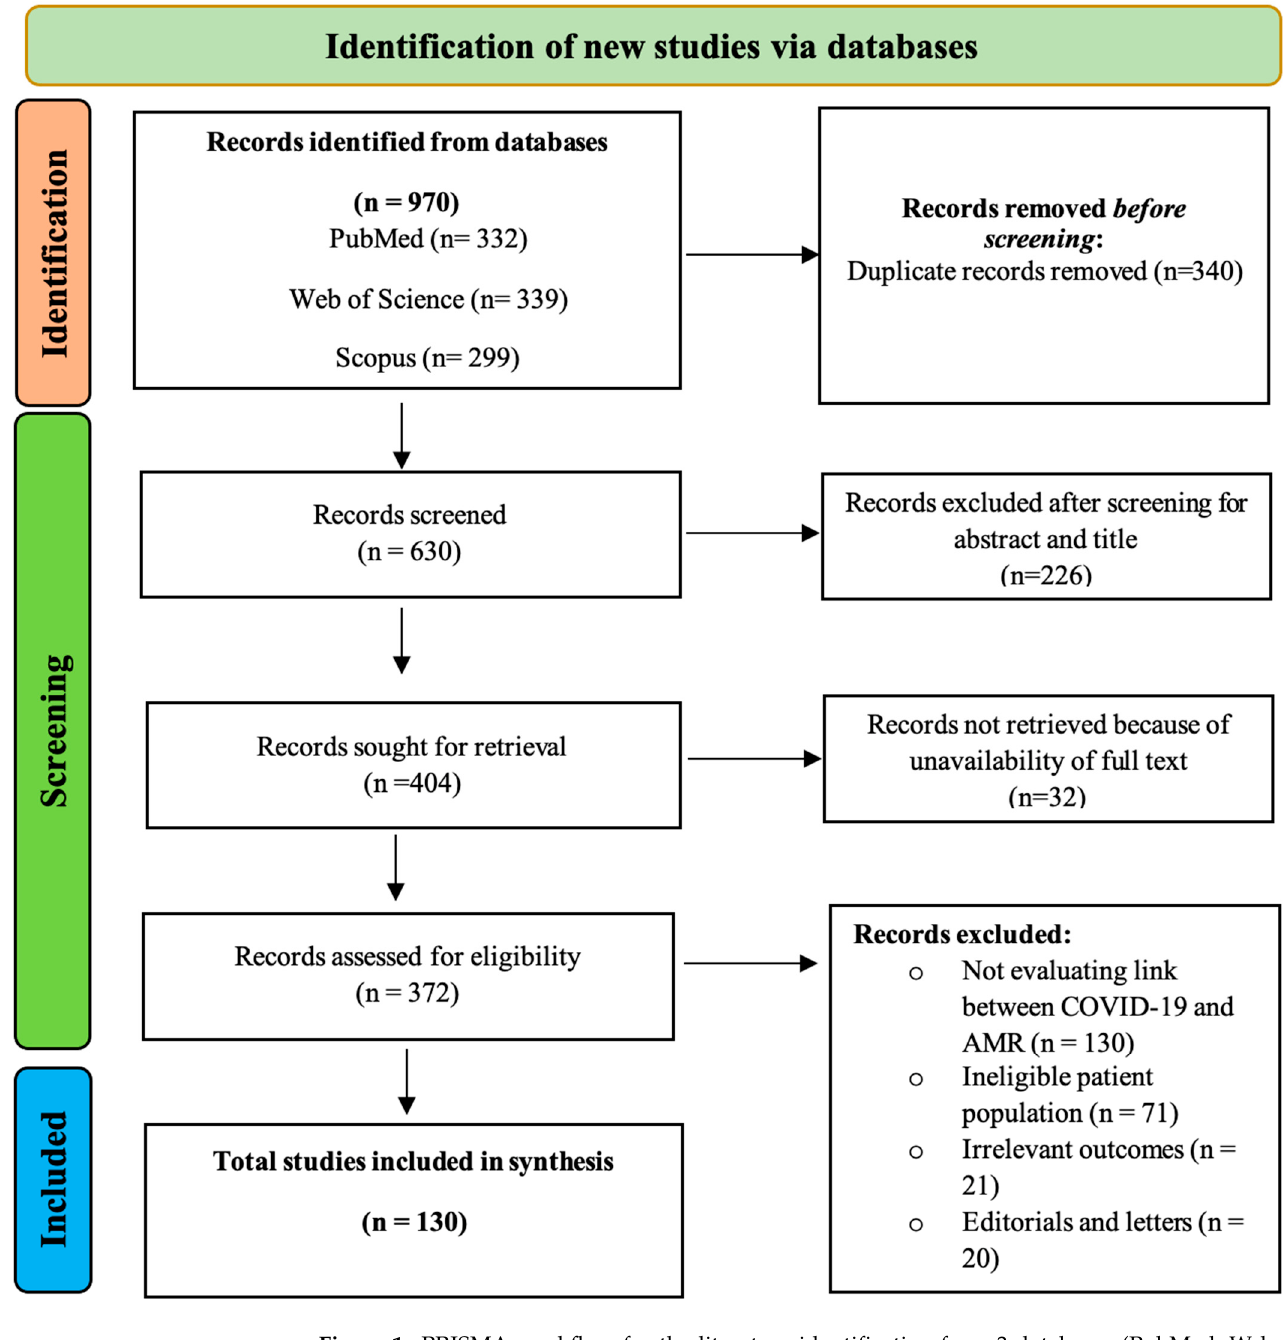
Figure 1. PRISMA workflow for the literature identification from 3 databases (PubMed, Web of Science, and Scopus), screening, and final selection of research studies for synthesis study. The exclu- sion criteria of the workflow include duplicate studies from multiple databases, screening based on the irrelevance of title and abstract, removal of records due to unavailability of full-text studies, studies not evaluating the link between COVID-19 and AMR, and having irrelevant outcomes, edi- torials, and letters.